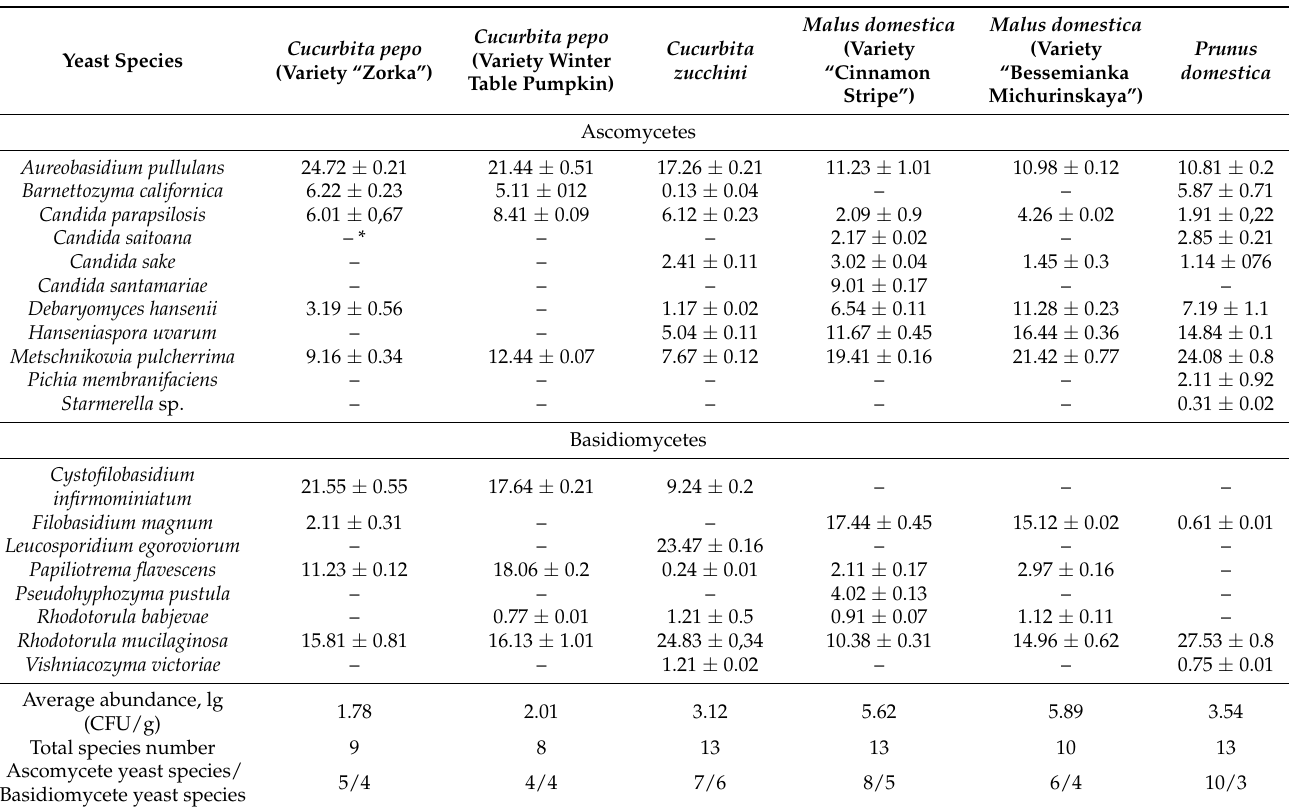
Table 2. Diversity of endophytic yeasts obtained from ripe vegetables and fruits (relative abundance with standard